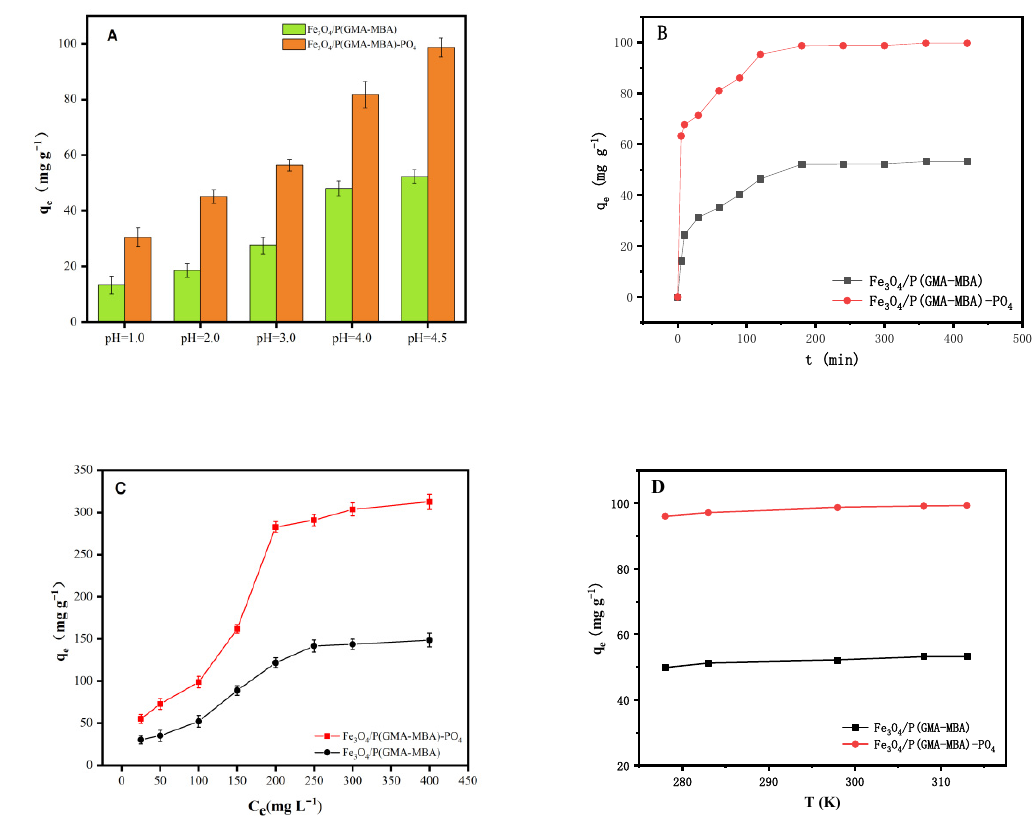
Figure 4. ( A ) Adsorption performance of Fe 3 O 4 /P (GMA-MBA) and Fe 3 O 4 /P (GMA-MBA)-PO 4 on uranium under different pH values; ( B ) influence of contact time on uranium adsorption capacity (C 0 = 100 mg L − 1 , T = 298 K, pH = 4.5, m/V = 0.4 g L − 1 ); ( C ) effect of uranium concentration on adsorption capacity of Fe 3 O 4 /P (GMA-MBA) and Fe 3 O 4 /P (GMA-MBA)-PO 4 (T = 180 min, pH = 4.5, T = 298 K, m/V = 0.4 g L − 1 ); ( D ) thermodynamic image of U (VI) adsorbed by Fe 3 O 4 /P (GMA-MBA) and Fe 3 O 4 /P (GMA-MBA)-PO 4 (C 0 = 100 mg L − 1 , pH = 4.5, m/V = 0.4 g L − 1 ) .